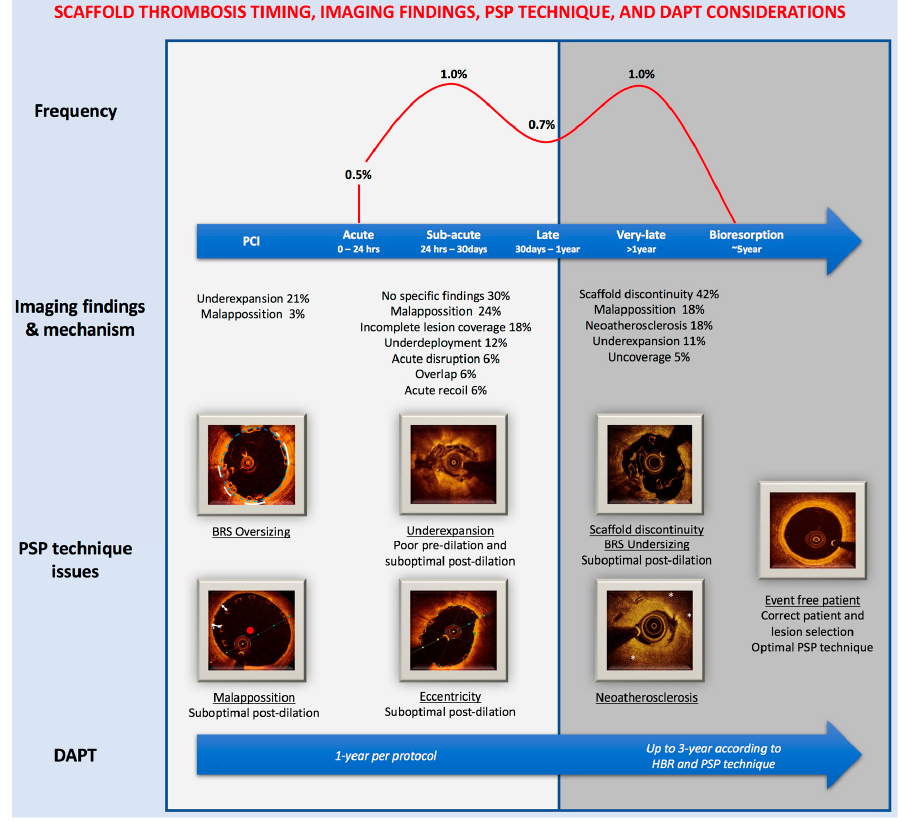
Figure 1. Scaffold thrombosis and PSP technique. The frequency of scaffold thrombosis according